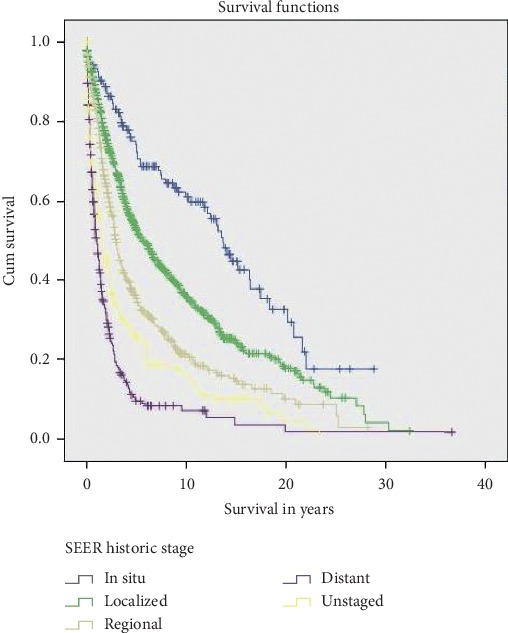
Kaplan–Meier plots showing overall survival among patients with anal canal adenocarcinoma (AA) based on pathologic stage.